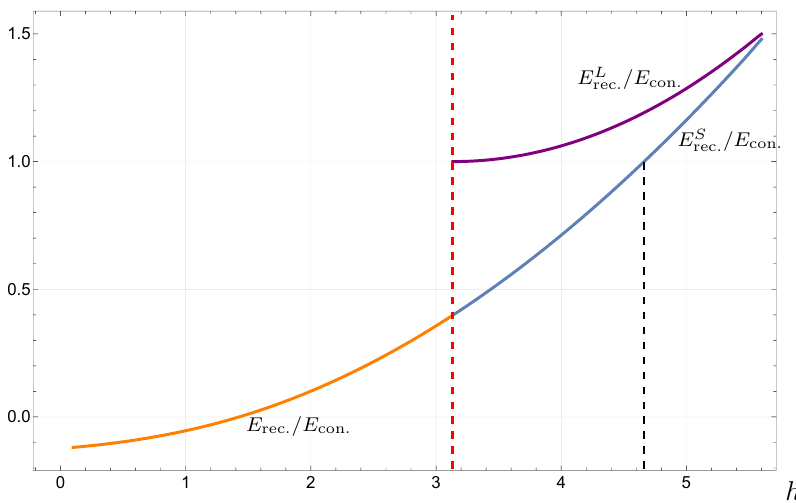
Figure 18 . Ratio of energies for the different configurations as a function of h/‘ , for the val- ues L = 2 ‘ and ϕ = π/ 16 . The red dashed line represents the value ˜ h/‘ = p π 2 − ϕ 2 above which two reconnected configurations exist. The black dashed line represents the value h ∗ /‘ , where E S /E con. = 1 and the first order phase transition rec.